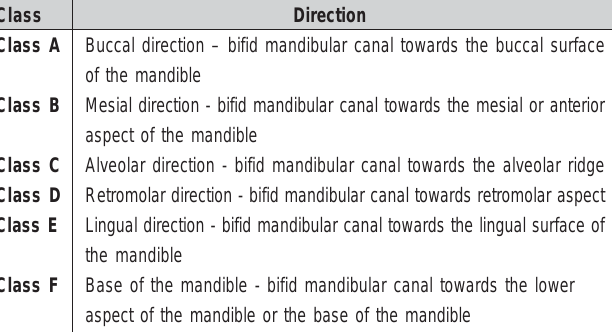
Table 1 - Classification of bifid mandibular